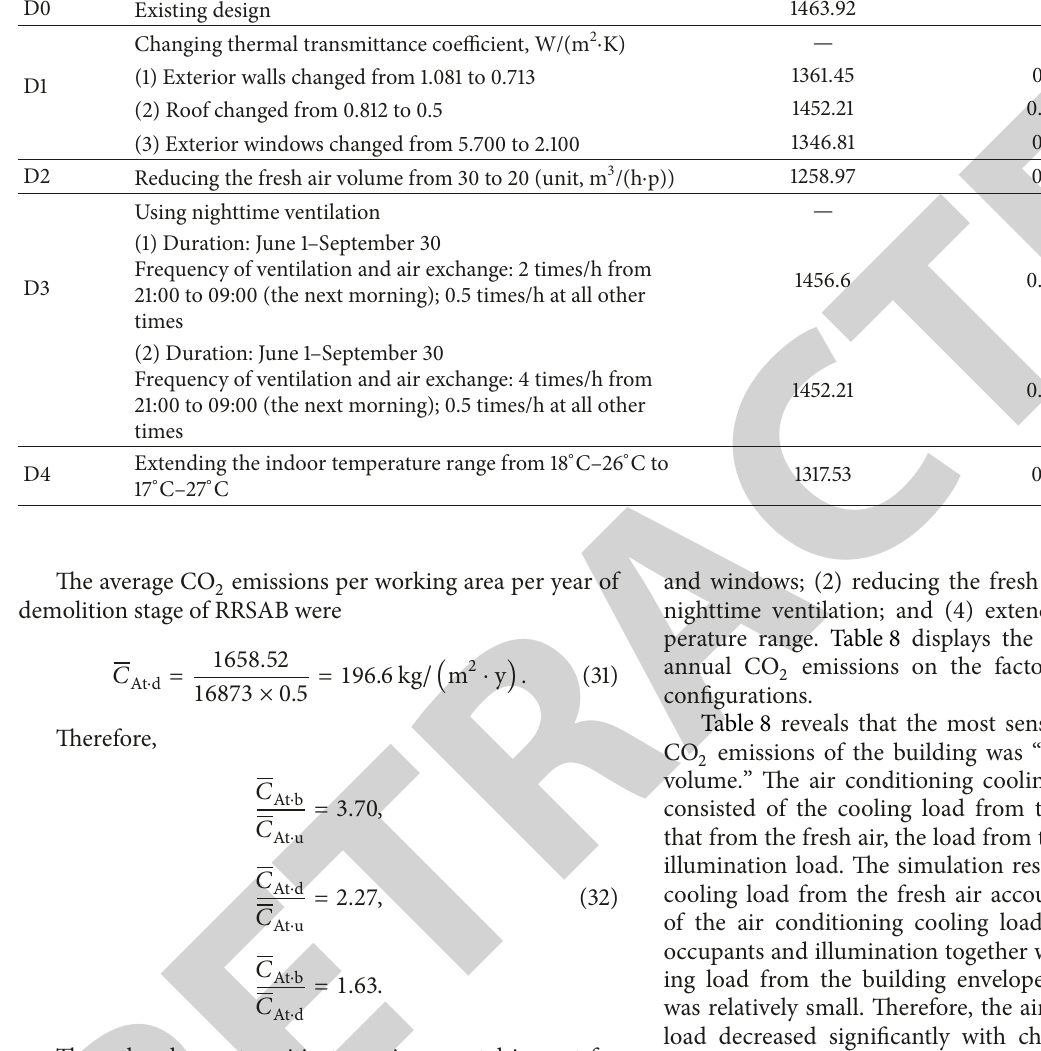
Table 8: The sensitivity analysis of annual CO Design ID Changed to original